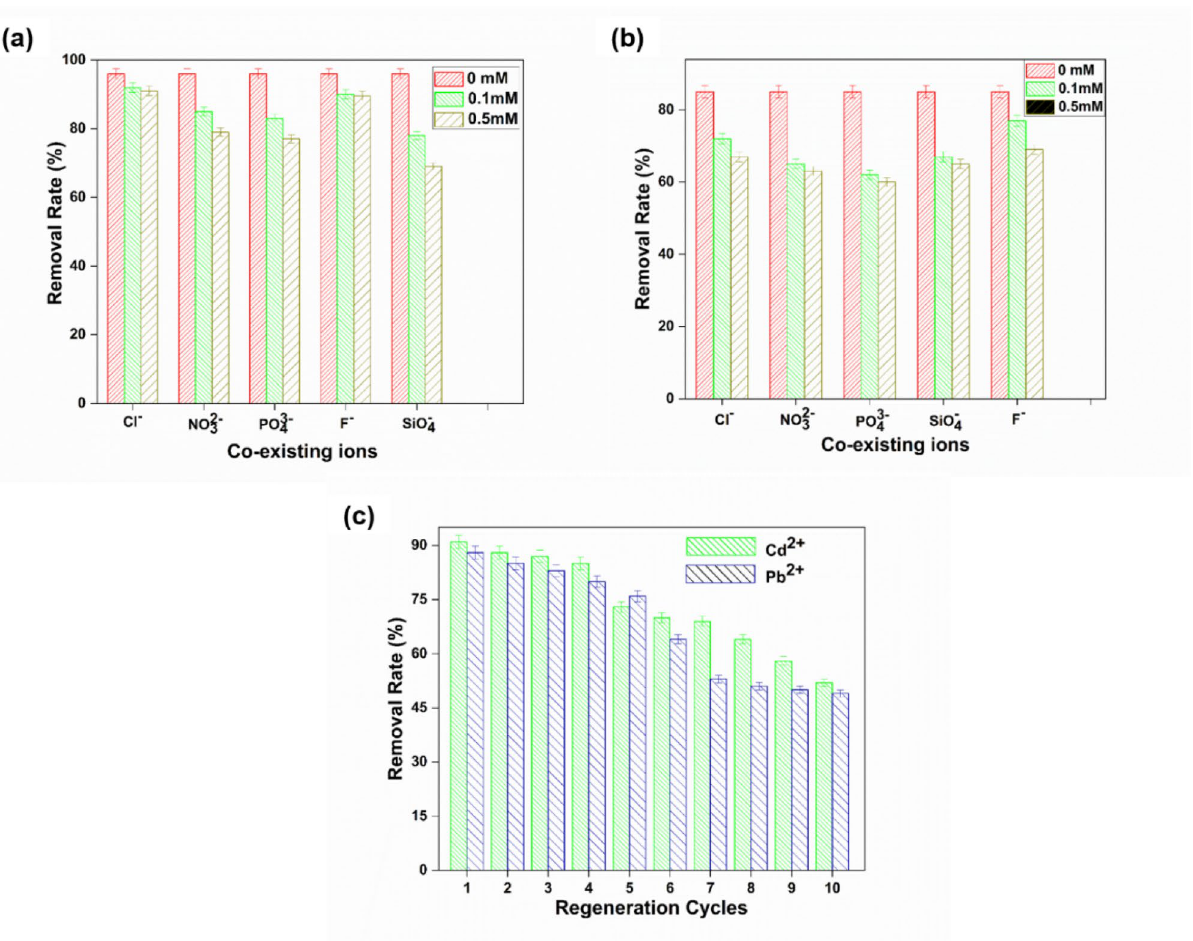
Figure 8. Effect of coexisting ions on the ( a ) Cd(II), and ( b ) Pb(II) adsorption by SP-5 ENMs, and ( c ) recycle and reusability performance of the SP-5 ENMs for Cd(II), and Pb(II)